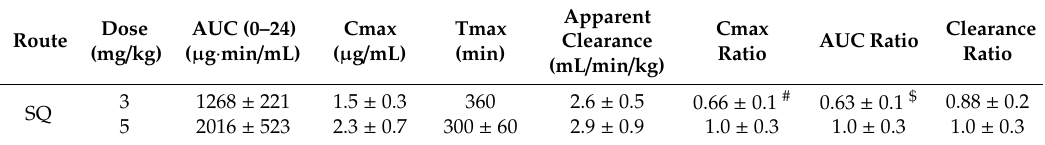
Figure 2. Plasma concentration-time profiles of the high-affinity bivalent TfRMAb following SQ injection. Mice were injected with TfRMAb (3 mg/kg or 5 mg/kg) via the SQ route and plasma samples were collected at 3 h (180 min), 6 h (360 min), and 24 h (1440 min) following injection. Plasma concentrations are shown as either µg/mL ( a ) or %ID/mL ( b ). Data are shown as the mean ± SEM of n = 3 per dose per time point. Table 1. PK parameters for TfRMAb following SQ dosing in mice. Data is shown as the mean ± SEM of n = 3 per dose.